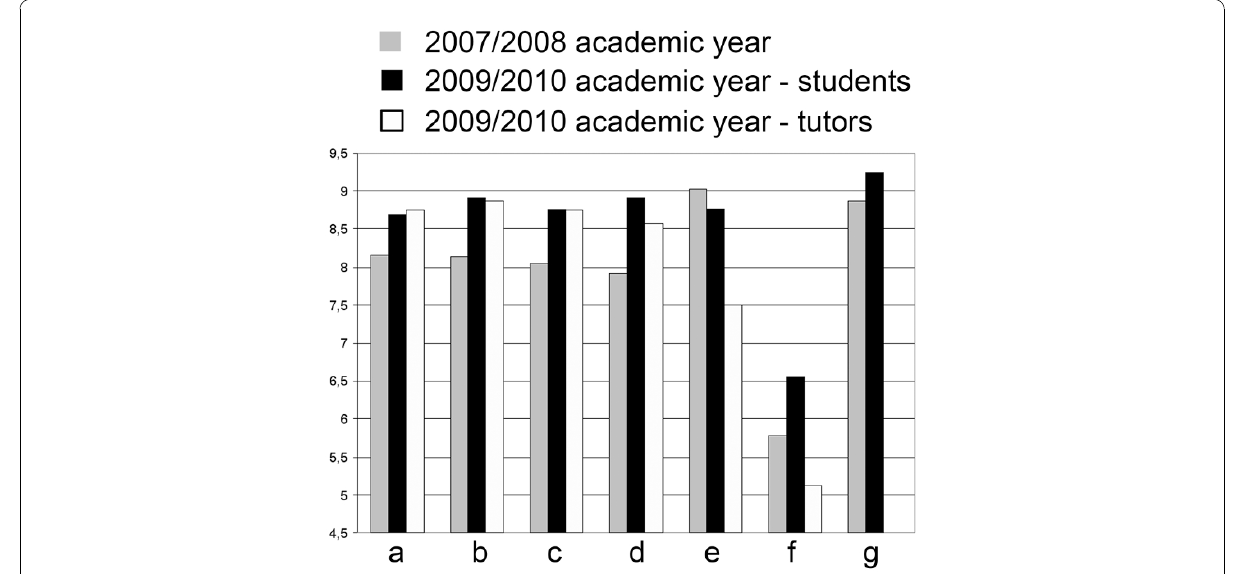
Figure 3 Results from the Student/Tutor satisfaction questionnaire . Answers for all questions were scaled between 1-10, where the higher score preferred digital over conventional microscopy and 5 denoted no difference between the methods. a- How much have you liked the practices with digital slides? b- Comparing to a conventional microscope, how much have you liked working with digital slides? c- Have you found the application user-friendly? d- Comparing to a conventional microscope, how user-friendly the application was? e- How do you rate the quality of the digital slides? f- How do you rate the speed of opening a slide during practices? g- How useful the Pathonet was for preparing the examination? (1-10: not useful - very useful).